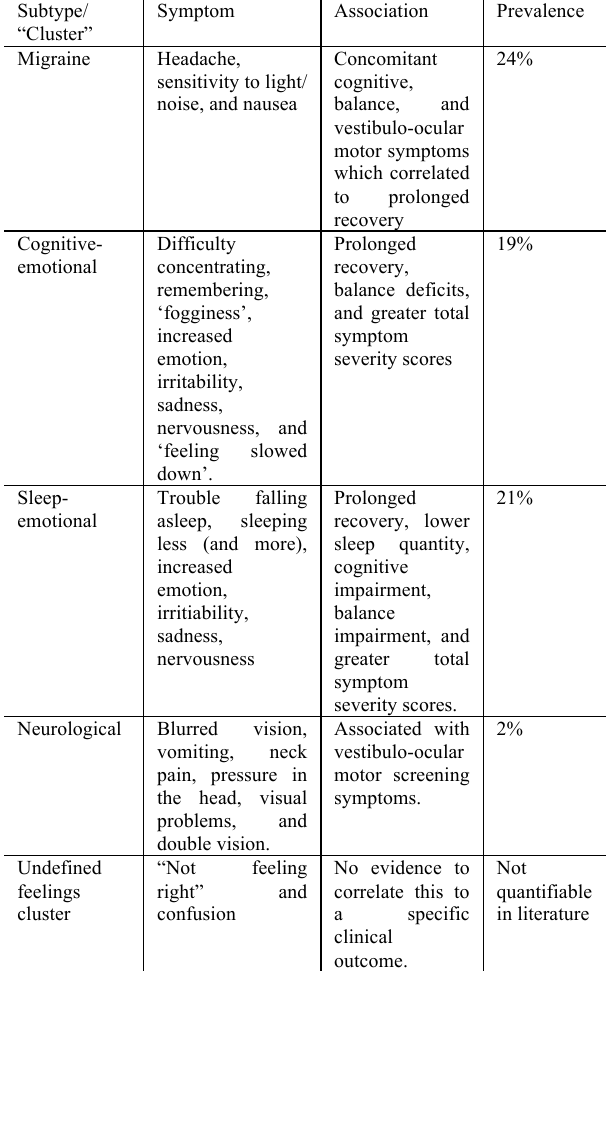
Table 2: Subtypes as described in (Langdon et al., 2020). Subtype/